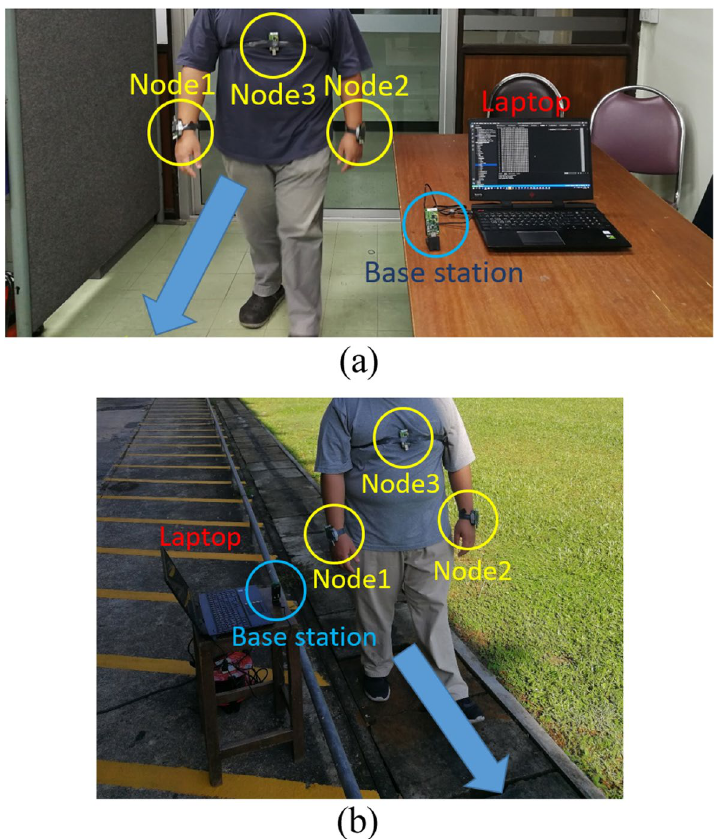
Fig. 7 Test case #4, a moving person; a the man walks in a straight line in the room, and b the man walks in a straight line in the outdoor